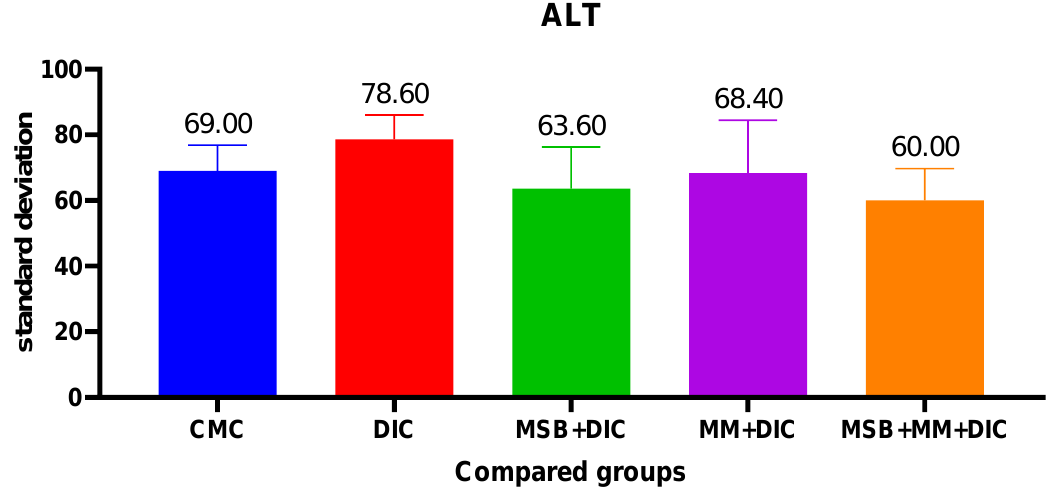
Figure 5. Mean value and standard deviation of ALT between analyzed groups. Group I-CMC, negative control group; group II-DIC, disease control group; group III-MSB+DIC, group receiving MegaSporeBiotic; group IV-MM+DIC, group receiving MegaMucosa; group V-MM+MSB+DIC, group receiving MegaSporeBiotic and MegaMucosa.